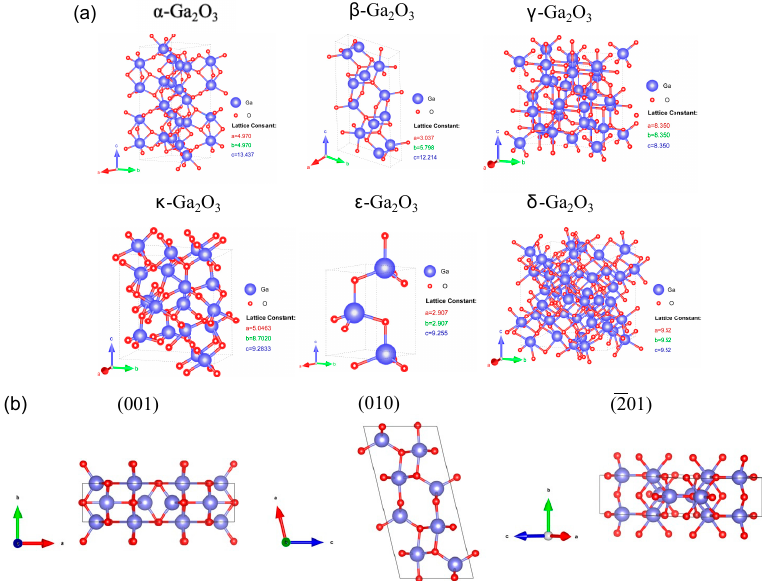
Figure 3. ( a ) Crystal structures of six polymorphs of Ga 2 O 3 . ( b ) The (001), (010), and (201) planes for β‐ Ga 2 O 3 . Original drawing using VESTA was done by us.